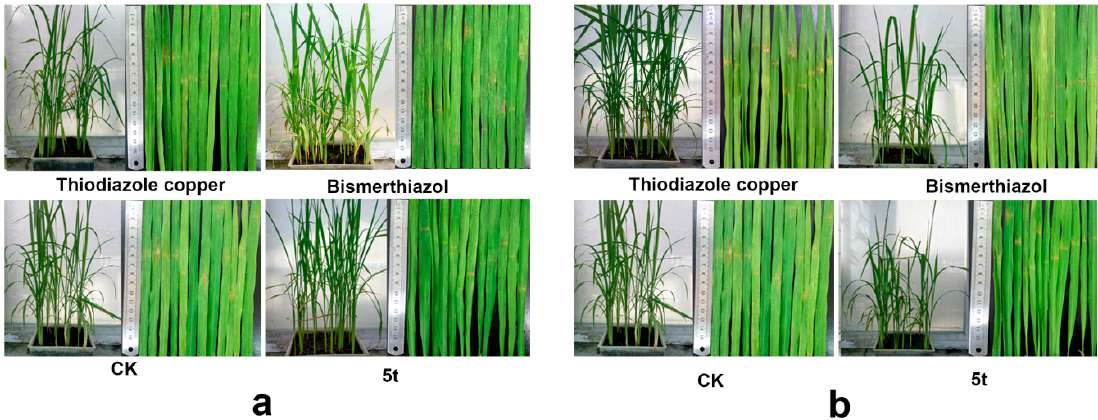
Figure 3. Protective ( a ) and curative ( b ) activities of compound 5t against rice bacterial leaf streak. Table 5. Protective activity of compound 5t against rice bacterial leaf